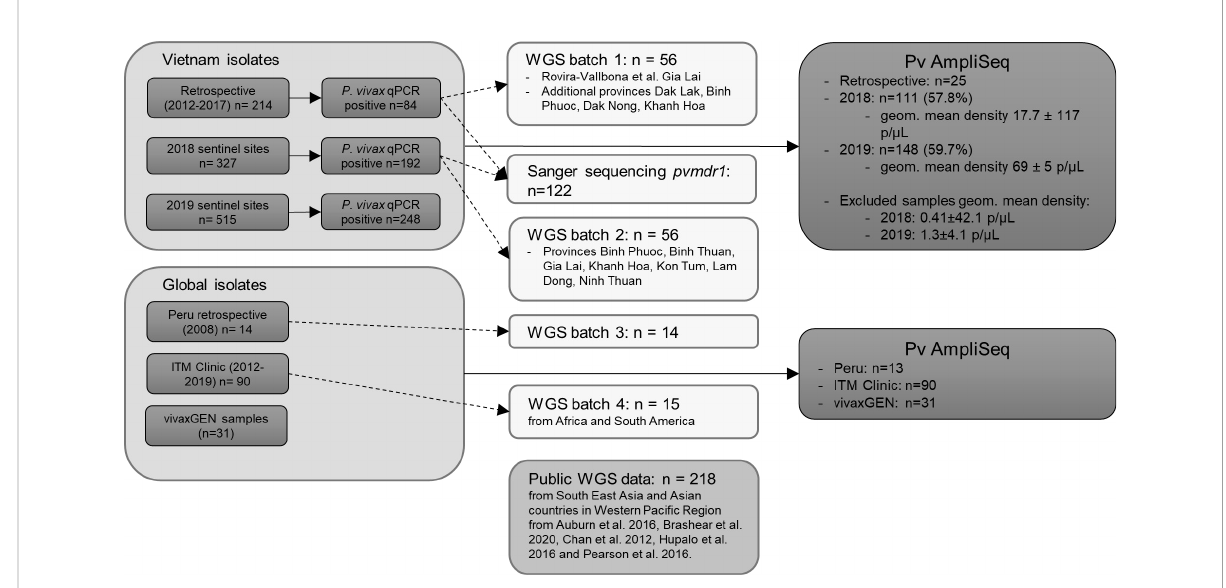
FIGURE 1 Flow-chart of sample selection for Pv AmpliSeq and WGS analysis. A database with details of samples selected for WGS can be found in Supplementary Table 1 and for samples and controls included in the Pv AmpliSeq meta data can be downloaded from https://microreact.org/